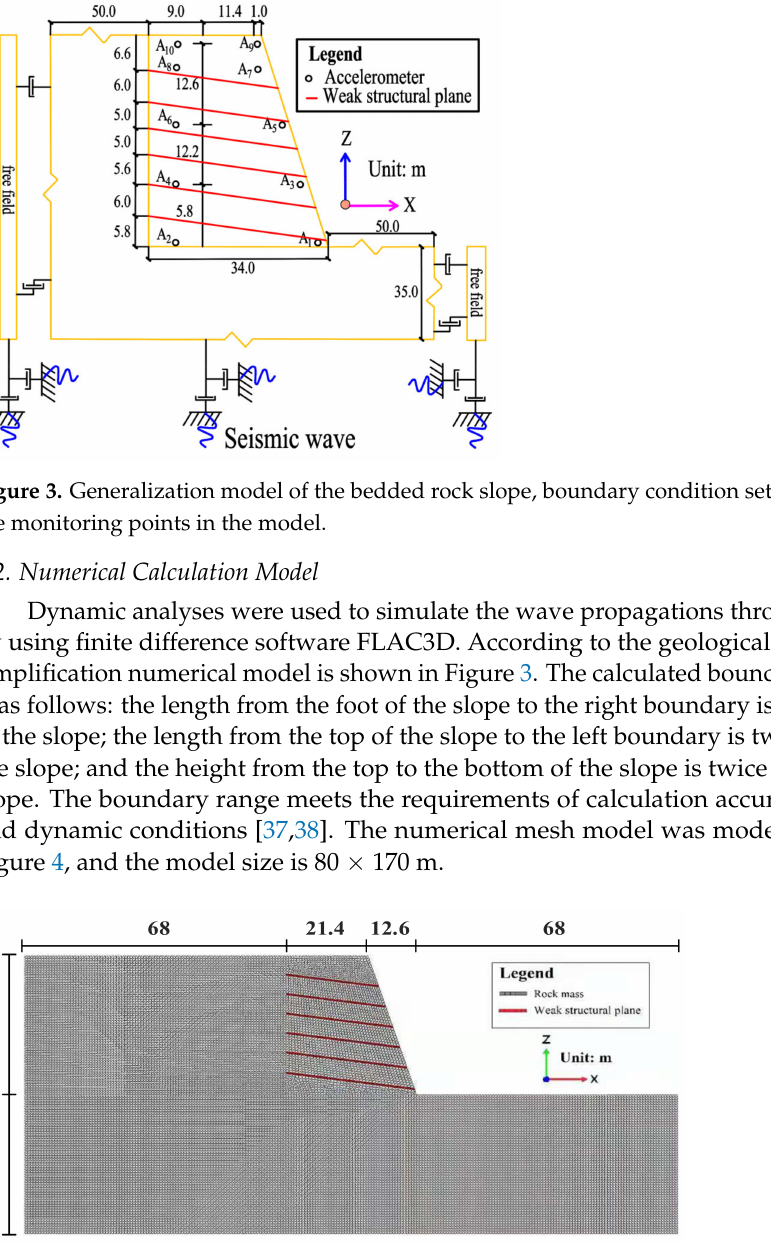
Figure 4. Numerical simulation model of the bedded slope and layout of the monitoring